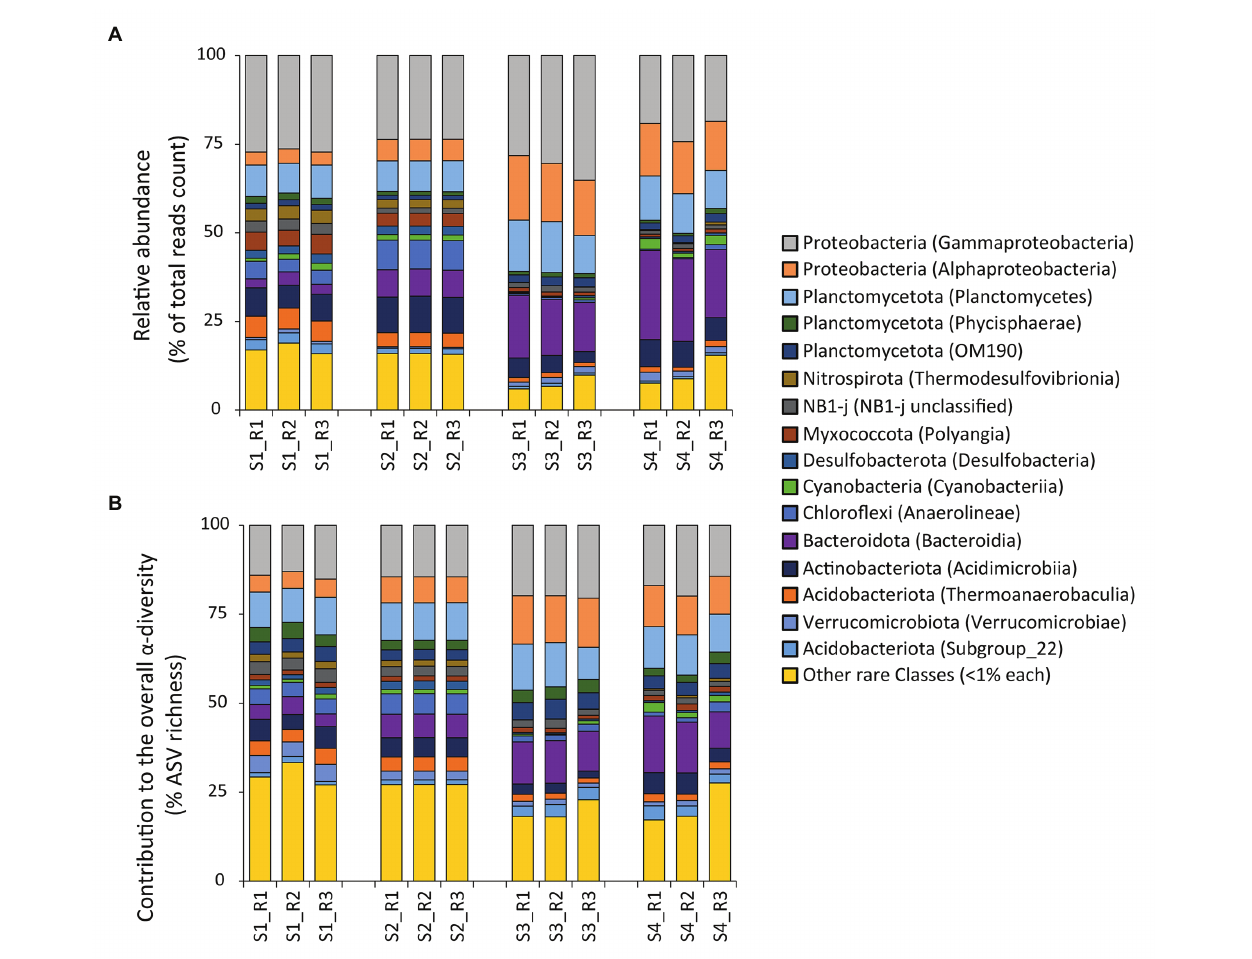
FIGURE 3 | (A,B) Composition of the prokaryotic assemblages at the benthic sites investigated. Reported are: (A) the relative abundance of each identified prokaryotic class (as % contribution to the total reads count), and (B) the contribution of each class to the overall α -diversity in terms of number of amplicon sequence variant (ASV) compared with the total ASV richness (expressed as